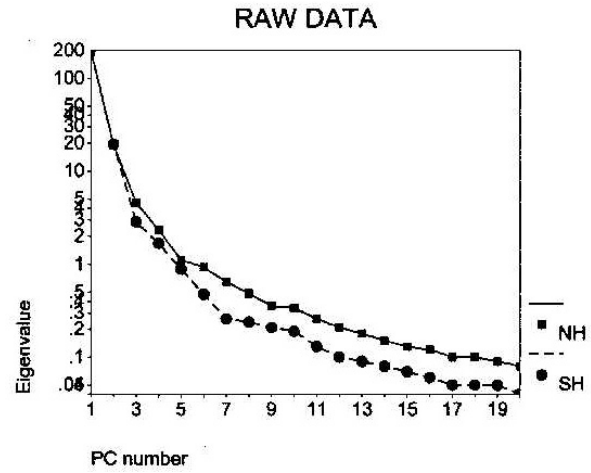
Fig. 1. Eigenvalue vs. PC number plot for raw data for Northern Hemisphere (NH) and Southern Hemisphere